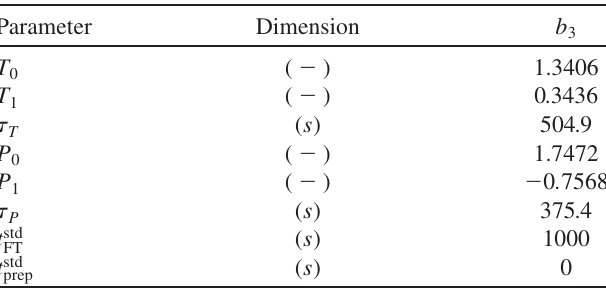
TABLE II. Parameters of Eq. (5).